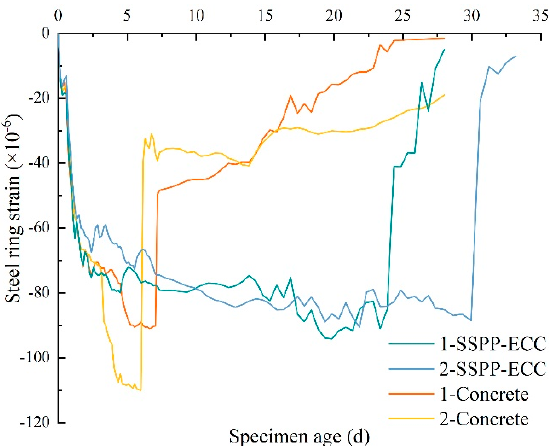
Figure 17. Shrinkage strain–time curve.